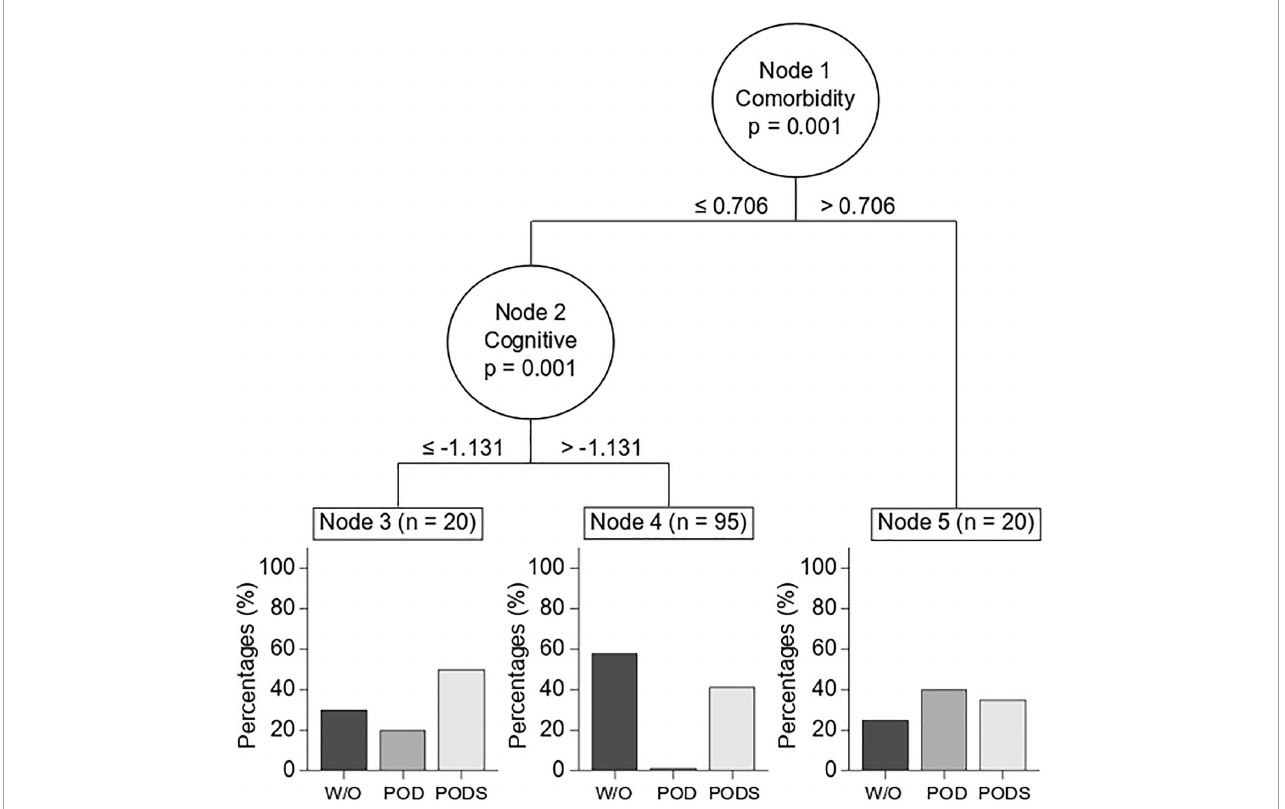
FIGURE2 Conditional classification tree ( post hoc analysis). To assess the ability to discriminate against patients who developed POD, variables were grouped into three different dimensions (comorbidity, cognition, and motor). The dimensions of comorbidity (Node 1) and cognition (Node 2) showed a significant level of discrimination against patients who developed POD. Nodes 3, 4, and 5 show the incidences of POD development in patients with an intermediate risk (node 3), low risk (node 4), and high risk (node 5) for developing POD.